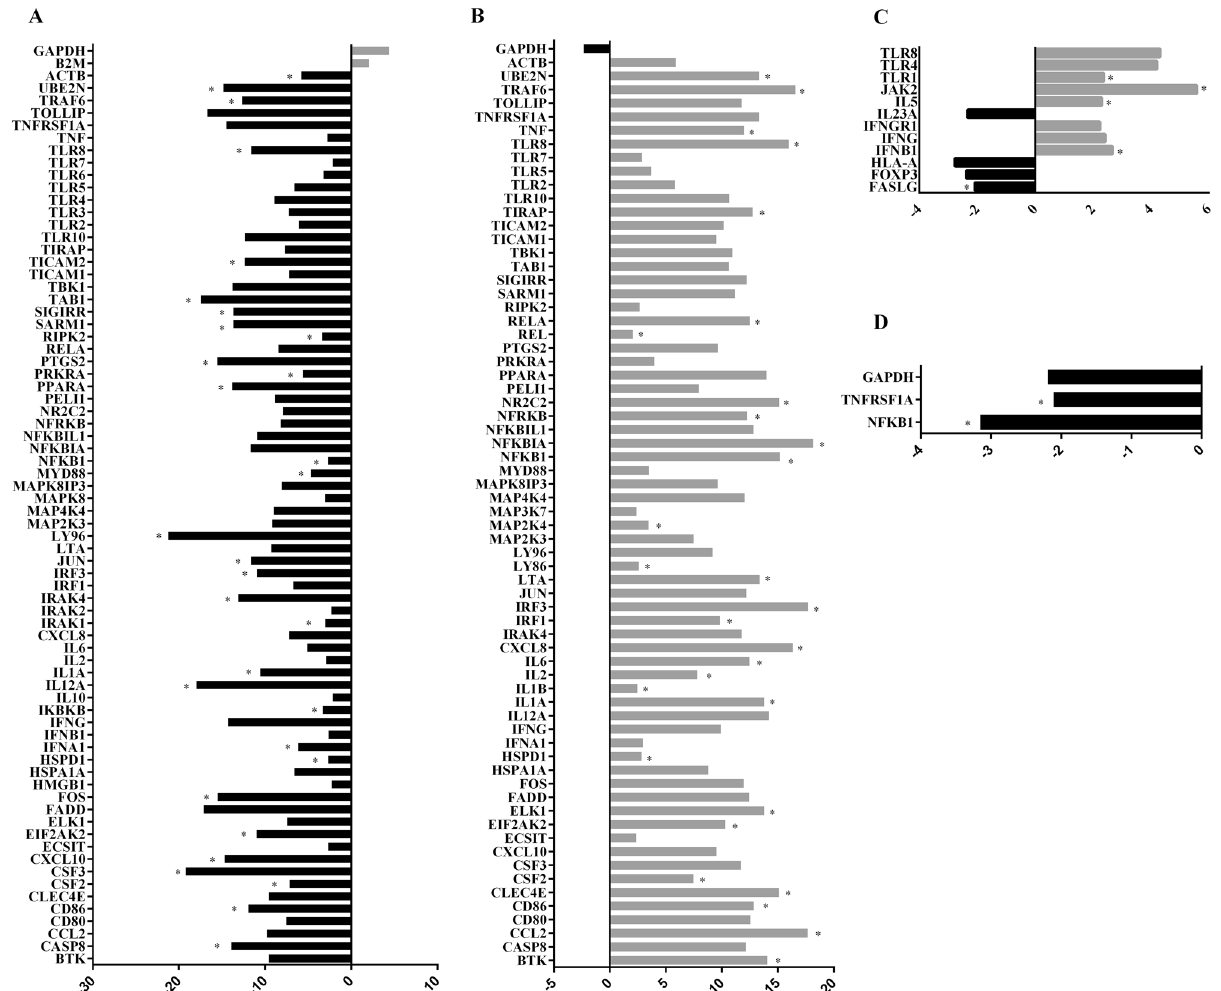
Figure 4. Gene expression analysis: up-regulated (grey) and down-regulated genes (black). The expression of genes was also evaluated in human monocyte samples of positive control groups (infected with S. aureus ), negative control group, treated with citral group, and treated and infected group. ( A ) In the group infected with S. aureus compared with negative control group, there were statistical differences involving 29 up-regulated genes ( BTK, CCL2, CD86, CLEC4E, CSF2, EIF2AK2, ELK1, HSPD1, IL1A, IL1B, IL2, IL6, CXCL8, IRF1, IRF3, LTA, LY96, MAP2K4, NFKB1, NFKBIA, NFRKB, NR2C2, REL, RELA, TIRAP, TLR8, TNF, TRAF6, and UBE2N ; P < 0.05). ( B ) Seventy-four genes were regulated in the group treated and infected compared with the positive control groups. There were statistical differences between 31 down-regulated genes: CASP8, CD86, CSF2, CSF3, CXCL10, EIF2AK2, FOS, HSPD1, IFNA1, IKBKB, IL12A, IL1A, IRAK1, IRAK4, IRF3, JUN, LY96, MYD88, NFKB1, PPARA, PRKRA, PTGS2, RIPK2, SARM1, SIGIRR, TBK1, TICAM2, TLR8, TRAF6, UBE2N, and ACTB . ( C ) Twelve genes were regulated in the group treated and infected compared with the negative control group. There were statistical differences between 4 down-regulated genes: FASLG, FOXP3, IL-23, and HLA-A , and there were statistical differences between 9 up-regulated genes: IFNB1, IFNG, IFNGR1, JAK2, TLR1, TLR4, and TLR8 . ( D ) Two genes were down-regulated in treated groups compared with the negative control group: TNFRSF1A and NFKB1 ( P <